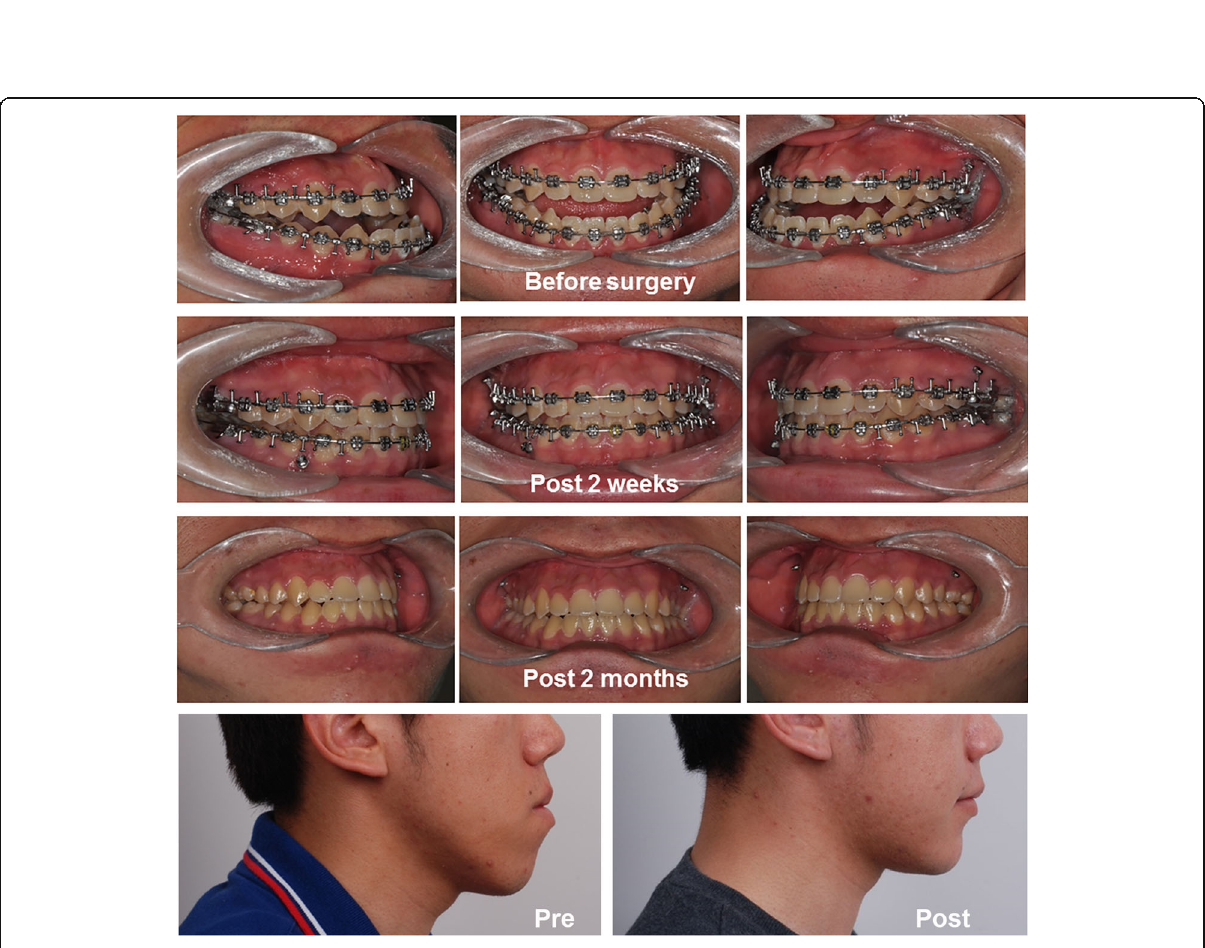
Fig. 3 A case with the conventional approach (21-year-old male). After 4months of presurgical orthodontics, Le Fort I osteotomy and bilateral sagittal split ramus osteotomy for mandibular setback had been performed. The overall treatment was finished after the 2 months of postoperative